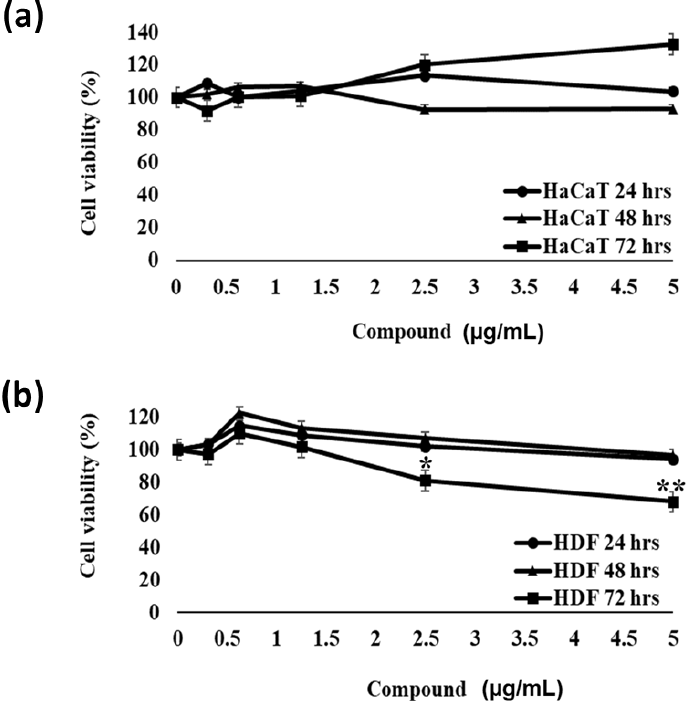
Figure 9. Effect of kaempferol-3- O - α -L-(2 (cid:48)(cid:48) ,4 (cid:48)(cid:48) -di- E-p -coumaroyl)-rhamnopyranoside (compound 3 ) on the viability of HaCat ( a ) and HDF cells ( b ). Cell viability was expressed as the percentage of MTT reduction with respect to control cells tested under the same conditions but in the absence of the compound under test. The experimental data represent the average of three independent experiments, each one carried out with triplicate determinations. Significant differences were indicated as (* p < 0.05) or (** p < 0.001) for treated versus control samples. Each experiment was carried out in triplicate.